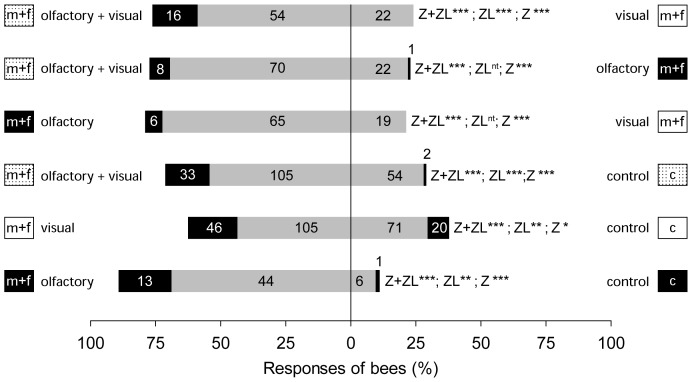
Responses of Apis mellifera to the olfactory and visual advertisement of Salix caprea flowering twigs.Olfactory and visual cues (alone or combined) of flowering sallow twigs were tested against an empty control cylinder (Experiment 1; lower three choice tests) or against each other (Experiment 2; upper three choice tests). Black = bees that landed after zigzagging (ZL); Grey = bees that zigzagged only (Z) without landing. The abbreviation “Z+ZL” refers to all bees that zigzagged with or without landing. The numbers in the bars indicate the absolute number of responding bees. Significant differences: *** p<0.001; ** p<0.01; * p<0.05, nt: a statistical test was not conducted due low number of bees. Symbols are as in Figure 2.